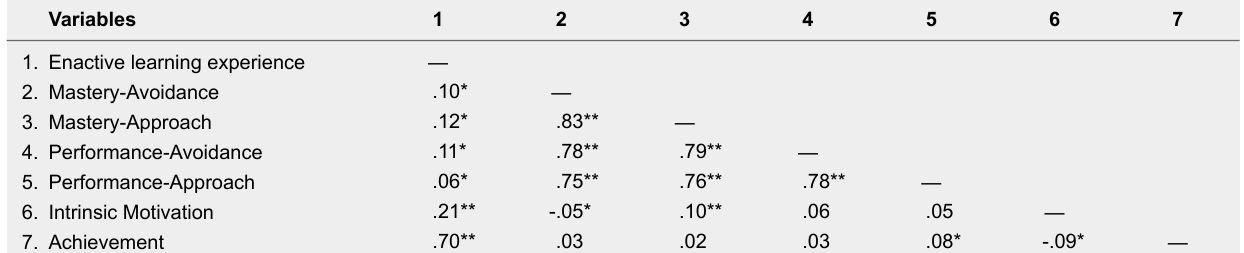
The Correlations among Variables in the Model (N = 277)